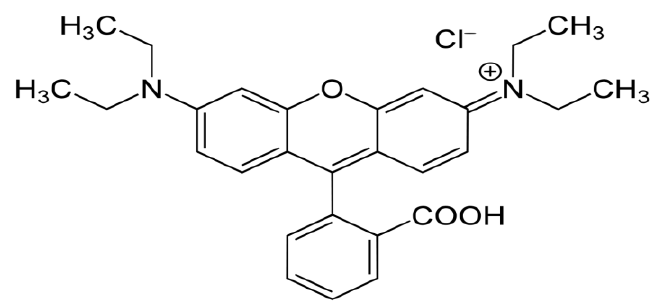
Fig. 1 Molecular Structure of Rhodamine – B